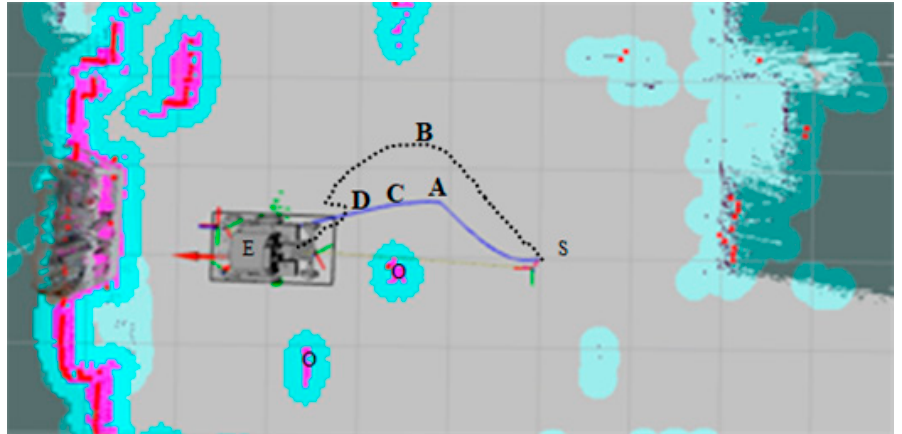
Figure 17. Paths that the wheelchair drove during autonomous and manual driving (S: start point, O: obstacle, E: end point, A: the farthest point from the straight path during autonomous driving, B: the farthest point from the straight path during manual driving, C: the closest point from the center of the obstacle in the detour to avoid obstacles during autonomous driving, and D: the closest point from the center of the obstacle in the detour to avoid obstacles during manual driving).